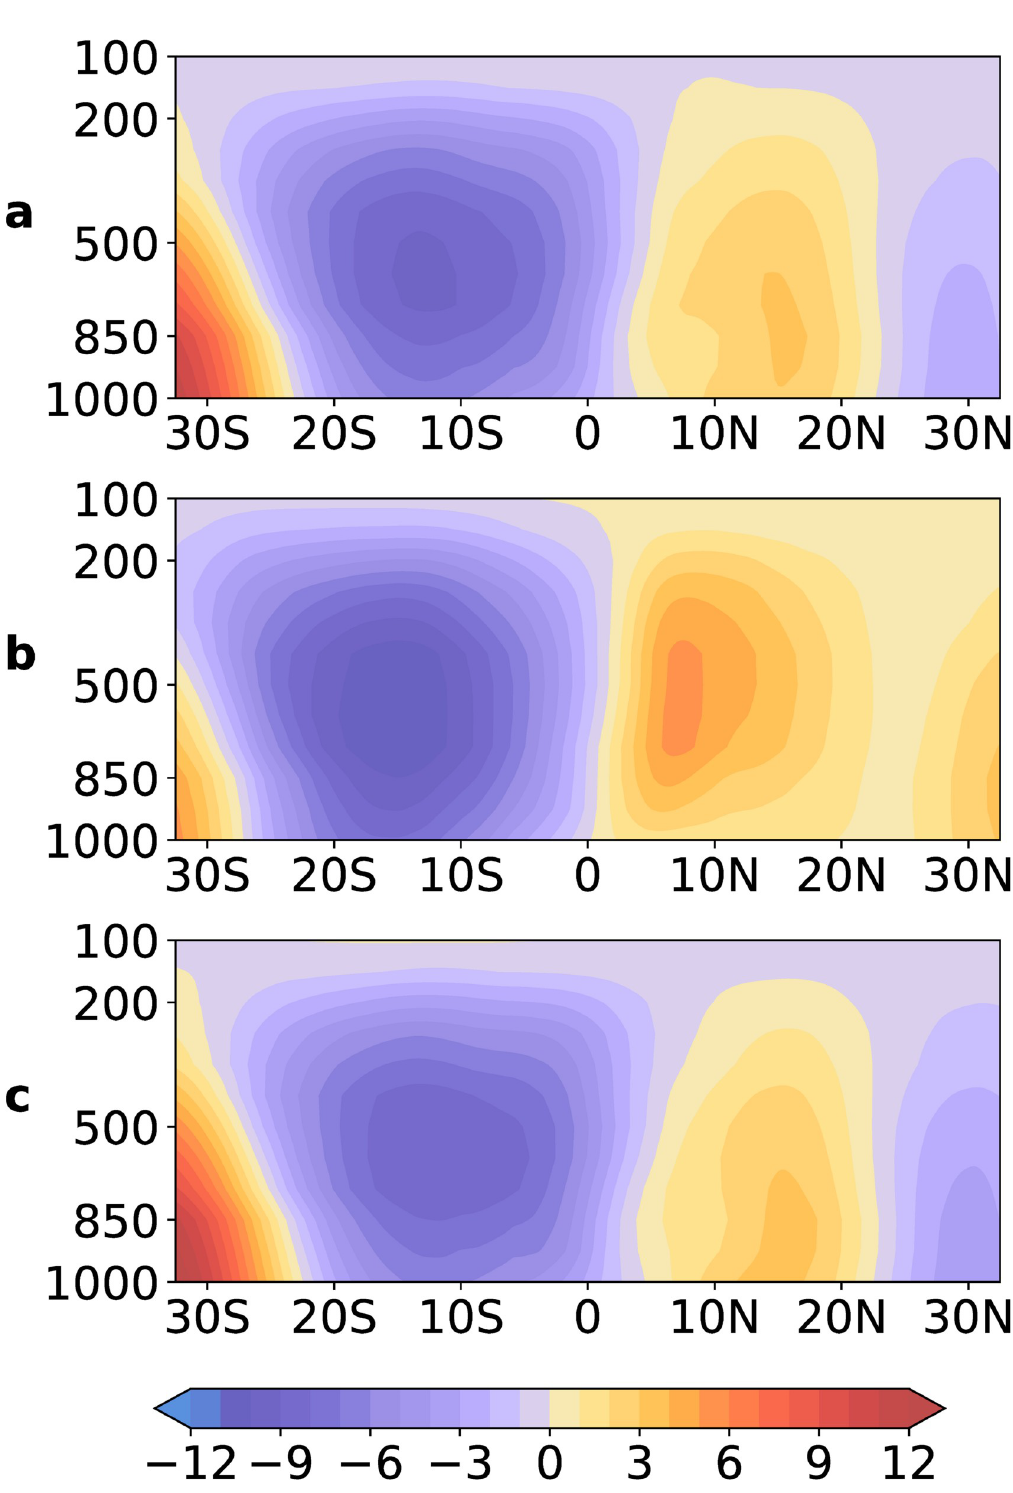
Fig 3. Composite MCA from May to October during the developing years of eight El Ni ñ o events: a, composite MCA from May to October during eight El Ni ñ o developing years for a total of 48 months; b, without the updraft in the North Pacific; c, with the updraft in the North Pacific. Shaded areas indicate the MSF of MCA (unit: 10 10 kg s -1 ). The purple regions indicate counter-clockwise movement and the red or yellow areas indicate clockwise movements.